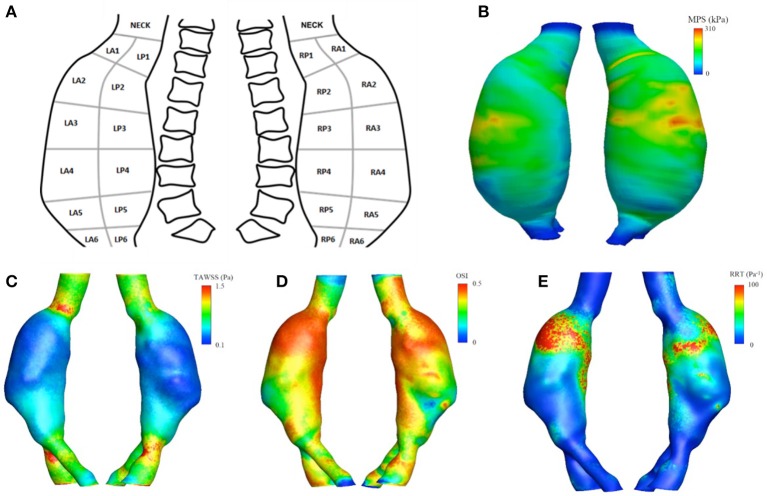
Upper panel (A) schematic representation of the surgery map used for tissue collection. (B) The maximum principal stress (MPS) field obtained from the finite element analysis. Lower panel: aortic luminal surface distribution of WSS-based hemodynamic descriptors, in detail (C) TAWSS, (D) OSI, (E) RRT.